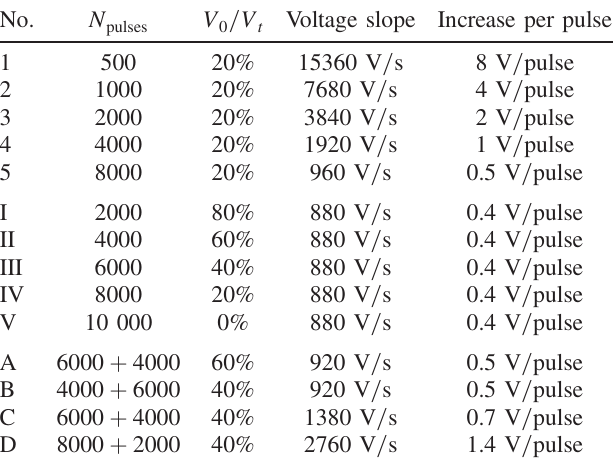
TABLE I. The voltage recovery scenarios applied in the experi- ments with the linear voltage ramp (one slope). The first column shows symbol each measurement is denoted as. The total number of ramping pulses N and the fraction of the starting voltage pulses V V 0 to the target voltage t are shown in the second and third column. The final two columns contain the corresponding overall ramping slopes and the ramp rates (voltage increase per pulse), respectively. The last measurement set included scenarios with pulsing at a constant voltage before the start of the voltage